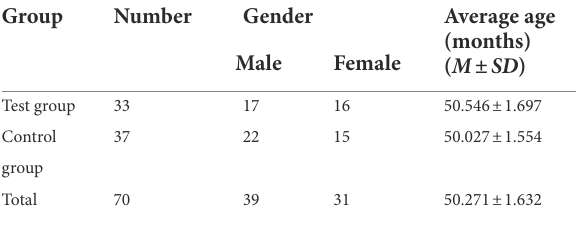
TABLE 4 Distribution and average age of children in different groups.